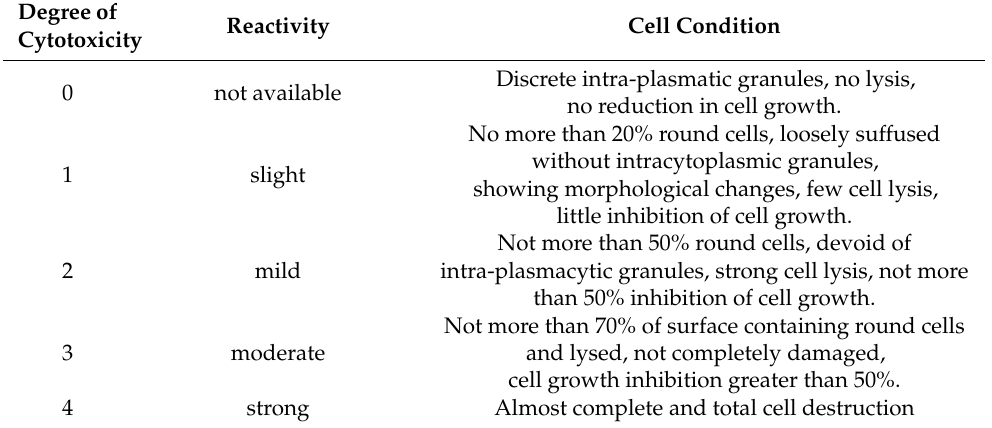
Table 1. Qualitative morphological classification of cellular cytotoxicity according to ISO 10993–5